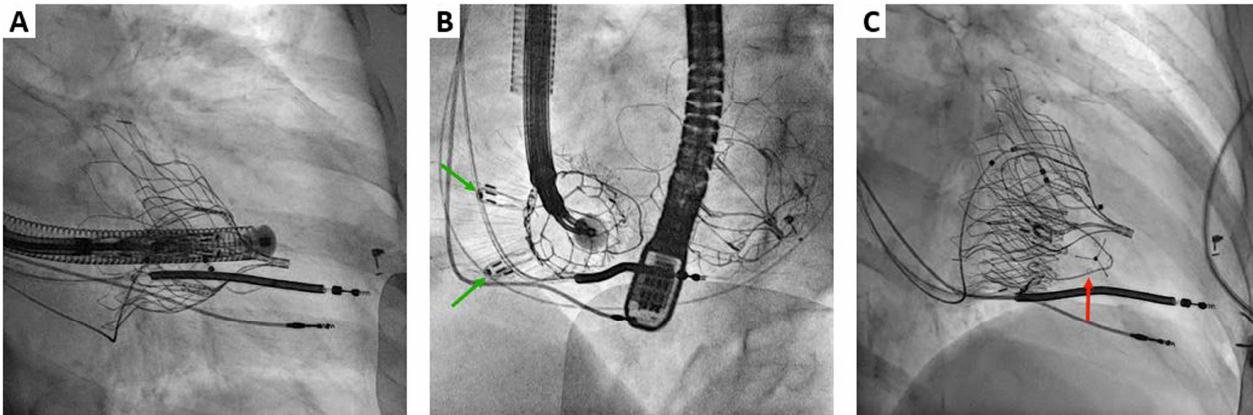
Figure 9. LuX-Valve Plus case. Fluoroscopic procedural monitoring. Adequate delivery system position to initiate prosthesis deployment ( A ). Orthogonal fluoroscopic projections of the deployed valve ( B , C ) (Green arrows: leaflet graspers. Red arrow: interventricular septal anchor). LuX-Valve Plus system is a feasible TR treatment and may reflect a safe alternative to conventional surgery in selected high-risk patients to improve symptoms, functional class, and quality of life. Further studies are warranted to provide data on long term outcomes and to evaluate the safety of the